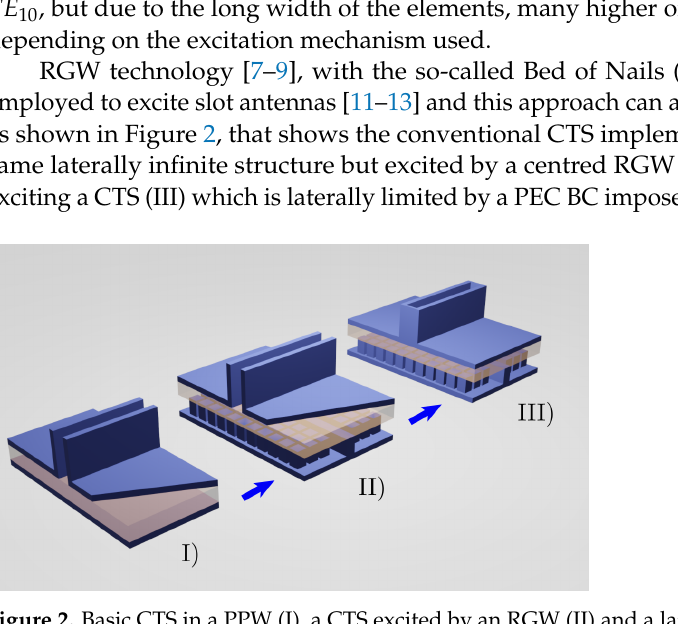
Figure 2. Basic CTS in a PPW (I), a CTS excited by an RGW (II) and a laterally-limited CTS excited by an RGW